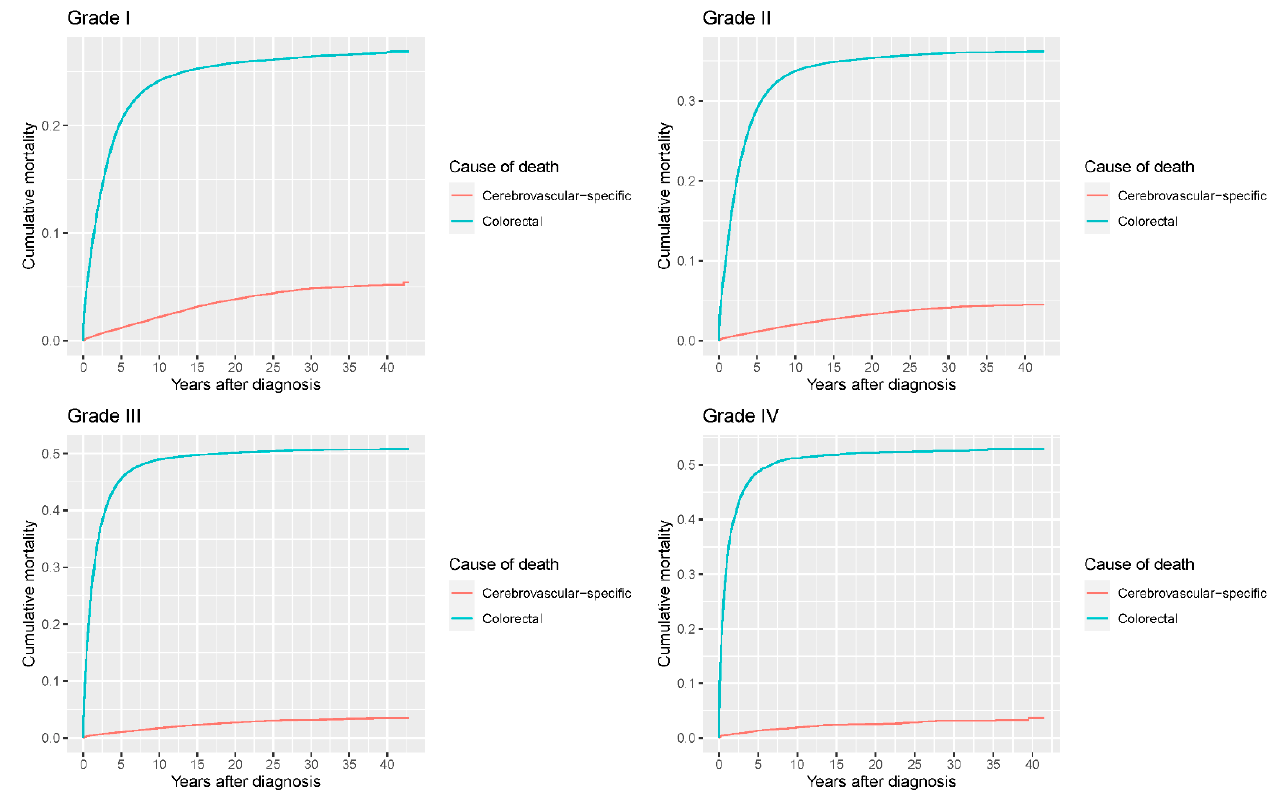
Figure 5. Cumulative cerebrovascular-specific and colorectal cancer-specific mortality stratified by tumor grade. Univariate analyses using a competing risk model were performed to test the relationship between tumor grade and CVSM in CRC patients ( p < 0.0001), and differences in cumulative mortality among different subgroups were analyzed by Gary’s test.